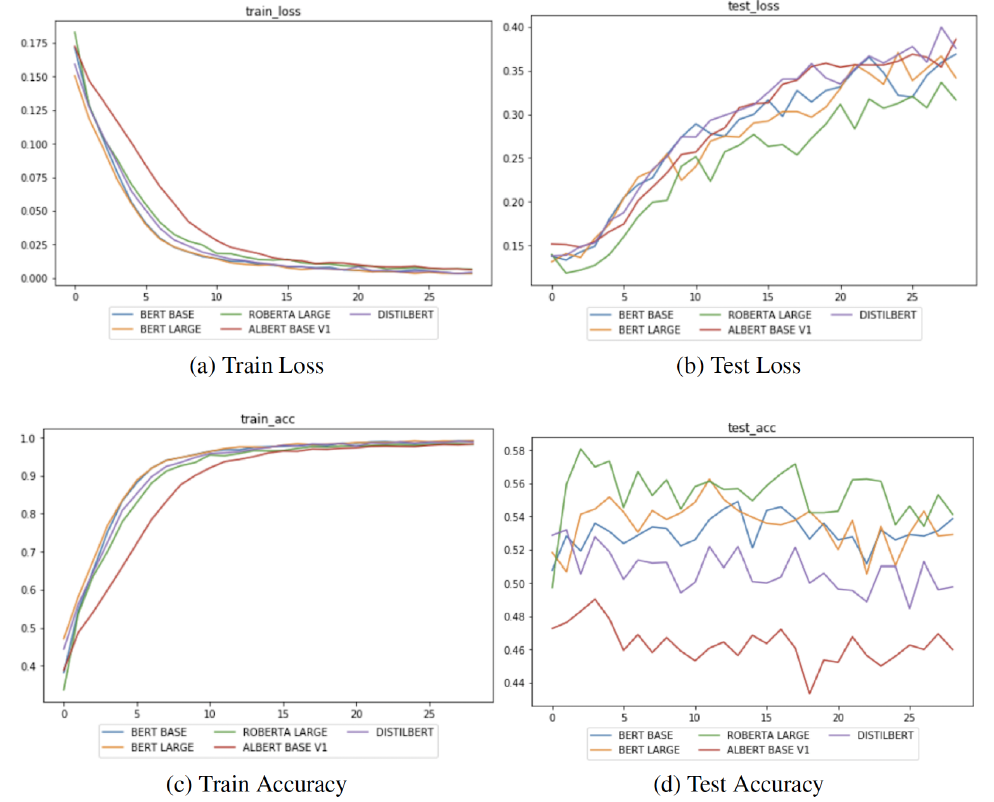
Figure 5. Plots of case study loss and accuracy per epoch for the 5 comparison models (figure adapted from the original work